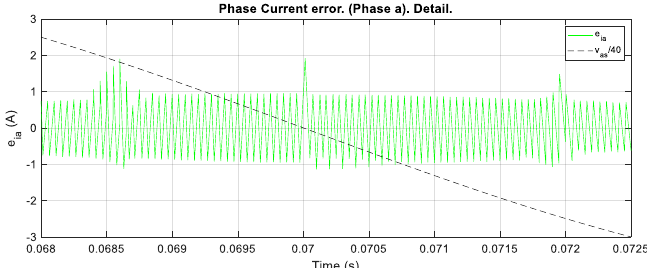
Figure 13. Current tracking error during detail 2 time interval.